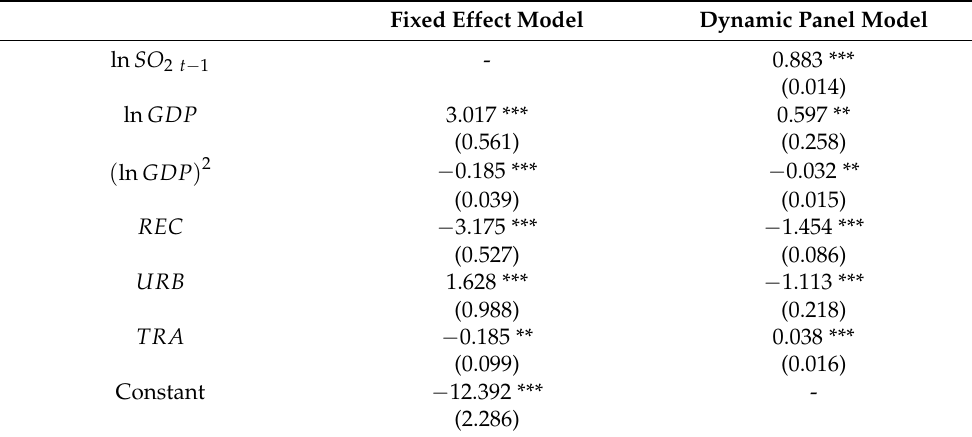
Table 3. Estimation Results for Sulfur Dioxide Emissions (SO 2 ).